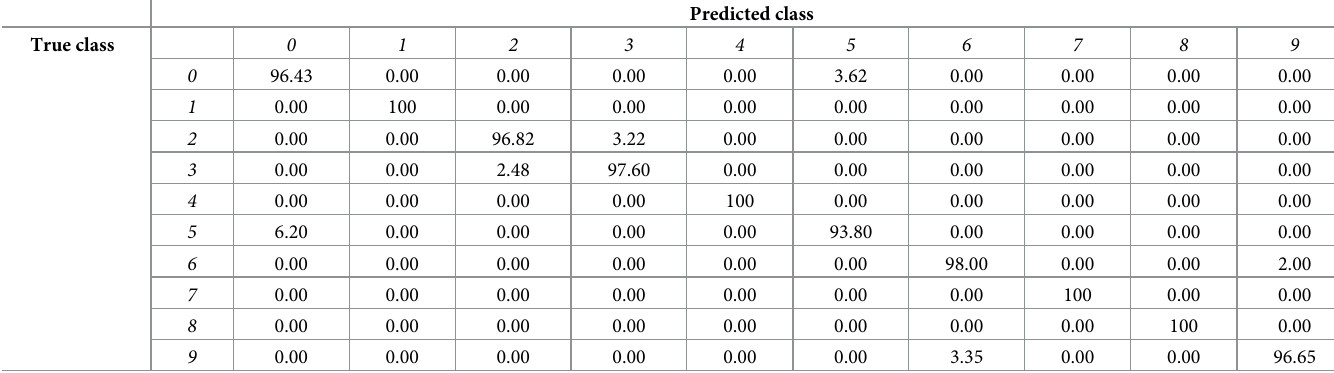
Table 4. Reported confusion matrix for all digits in the database PHND using DCNNs method.